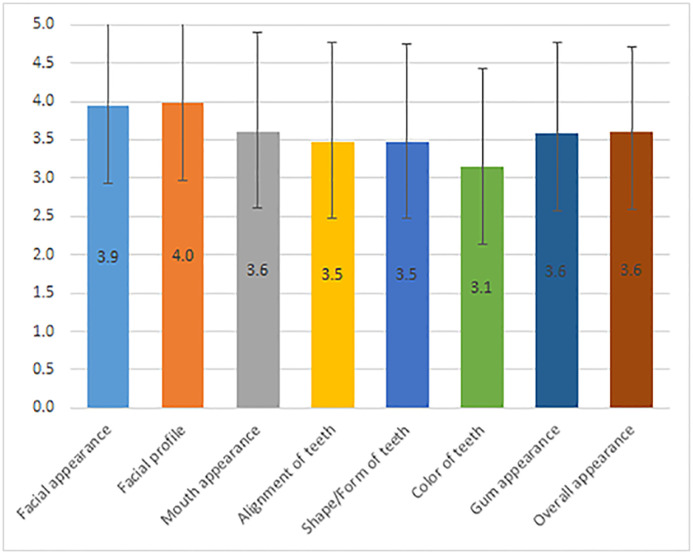
Means and SD of the 8 items of the OES-Ar for all sample.